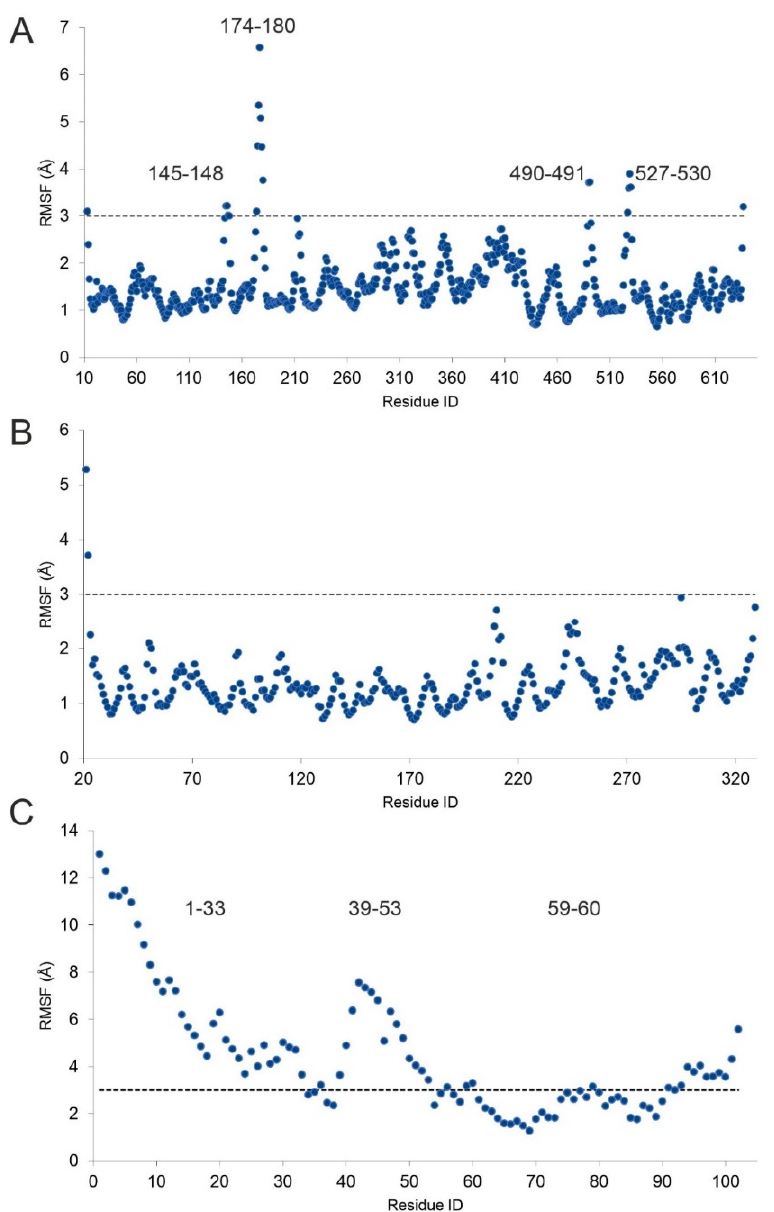
Figure 4. Root mean square fluctuation (RMSF) of each residue in the apo enzyme PRMT5 ( A ), MEP50 ( B ), and the unbound H4 ( C ) during 580, 580, and 1000 ns-long MD simulations, respectively. Regions with higher than 3 Å fluctuation are also marked at the top of the corresponding peaks.